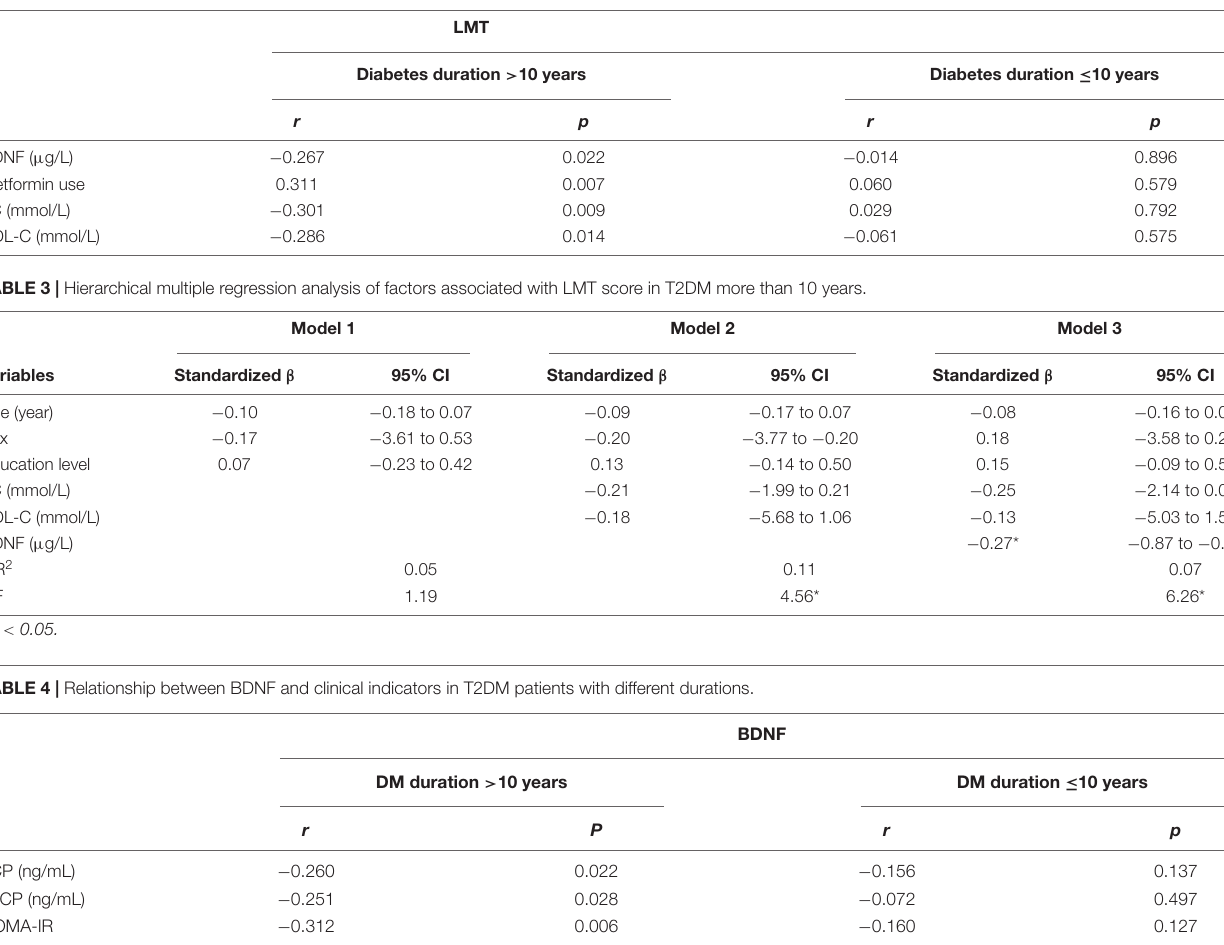
TABLE 2 | Partial correlation analysis between BDNF, clinical indicators, and LMT score of T2DM patients with different durations.